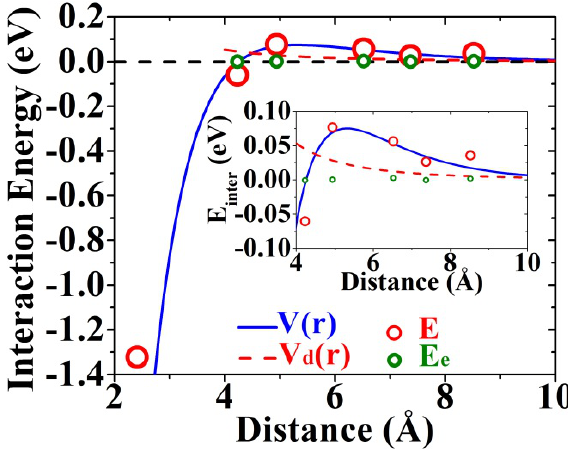
Figure 16. Interaction energy E (red large open circle symbols) and V (r) (blue solid line) of Fe–Fe adatoms on graphene as a function of Fe–Fe separation. E and V (r) (dash line) are elastic interaction and dipole-dipole interaction, d